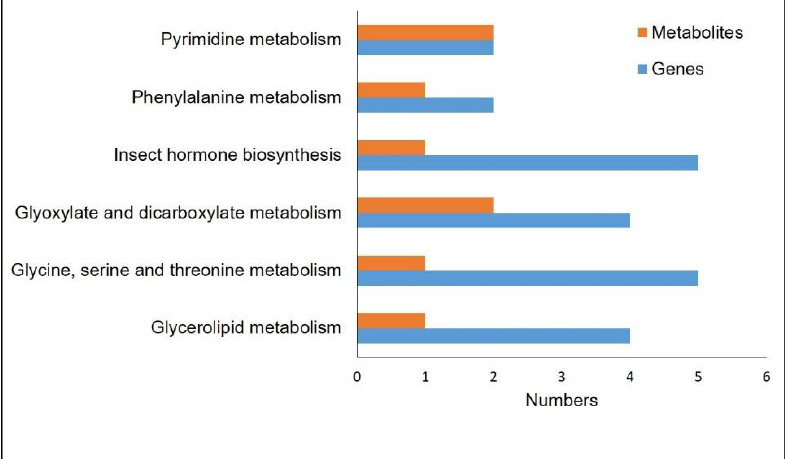
Figure 7. Integrated analyses of the transcriptome and metabolome on the KEGG pathways with the habanero-pepper diet. The specific KEGG pathway is labeled on the left, and the number of relative DEGs and differentially accumulated metabolites are on the right.